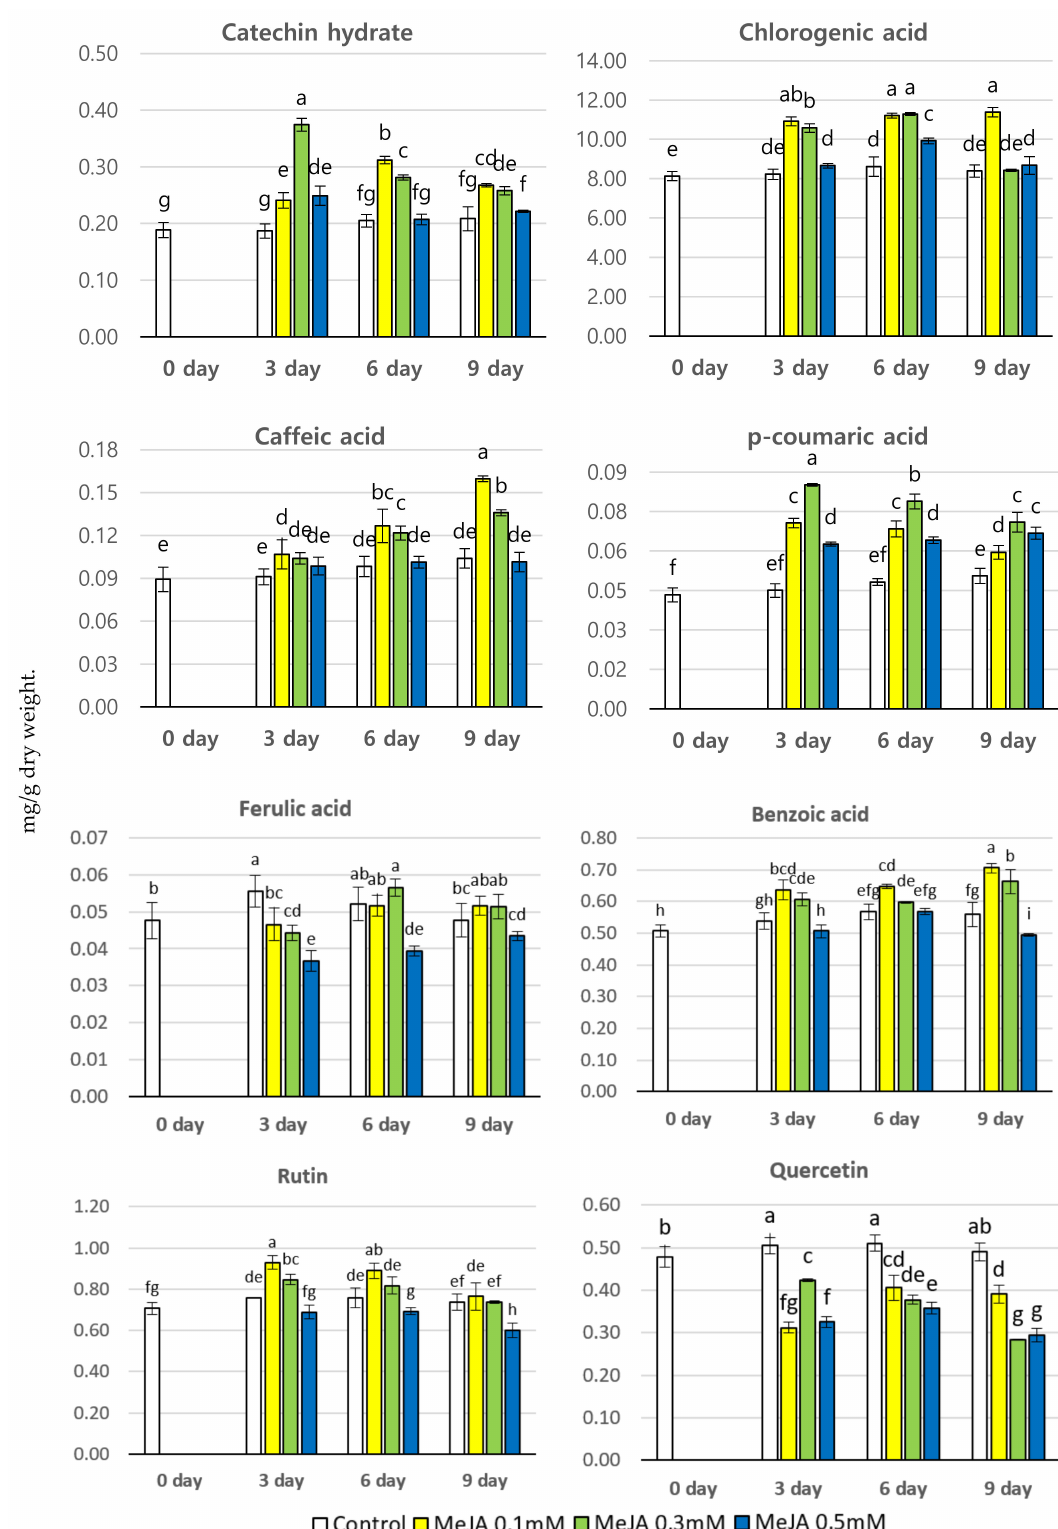
Figure 2. The content of phenolic compounds (mg / g dry wt.) in P. brachycarpa Nakai samples after treatment with di ff erent concentrations of methyl jasmonate (MeJA). The values marked above the bars with di ff erent letters (a–i) indicate a statistically significant di ff erence between treatments, as determined using DMRT ( p <